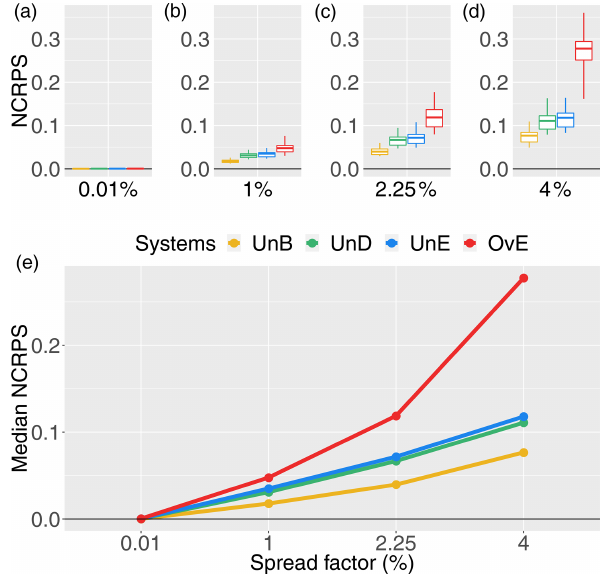
Figure 6. NRMSE score for 1d ahead synthetically generated fore- casts of different quality: unbiased system (UnB, yellow), underdis- persed system (UnD, green), underestimating system (UnE, blue) and overestimating system (OvE, red). Systems are based on en- sembles generated with four different spread factors (0.01%, 1%, 2.25% and 4%). (a–d) Boxplots represent the maximum value, per- centiles 75, 50 and 25, and minimum value over the 10 studied catchments. (e) Median score value.